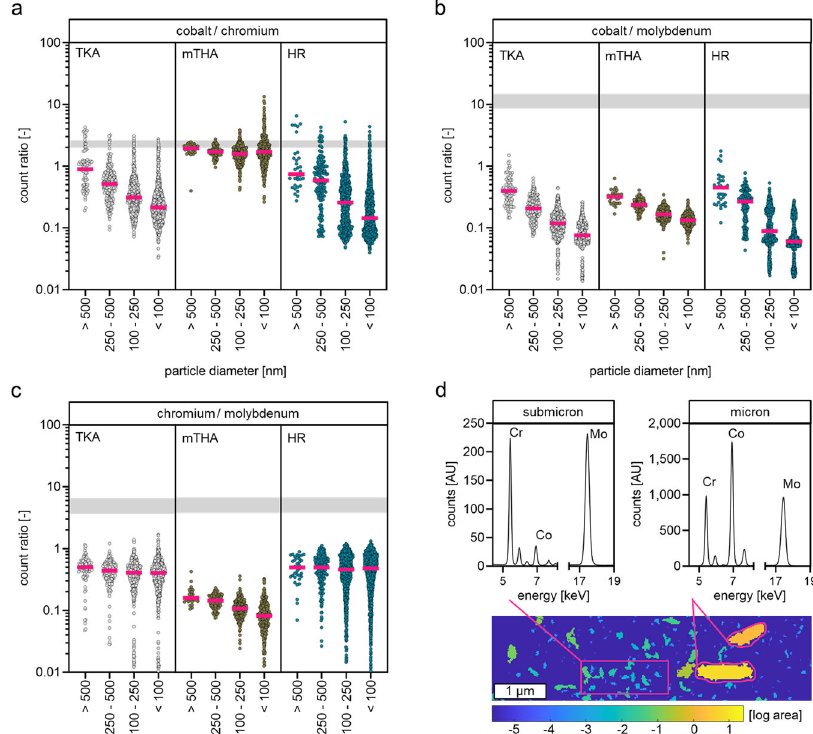
Fig. 5 Analysis of the elemental ratios of the CoCrMo particles located in the bone marrow revealed distinct differences of particle composi- tions with respect to particle sizes. a Particles released from total knee arthroplasty implants (TKA) and hip resurfacing implants (HR) indi- cate a distinct particle size-dependent decrease of Co to Cr ratios. Gray bar indicates the Co to Cr ratio in commonly used CoCrMo alloy (2.0 – 2.5). b Size-dependent Co to Mo ratio in particles released from all analyzed implant types. Gray bar indicates the Co to Mo ratio in commonly used CoCrMo alloy (8.6 – 14.7). c The Cr to Mo ratio is not